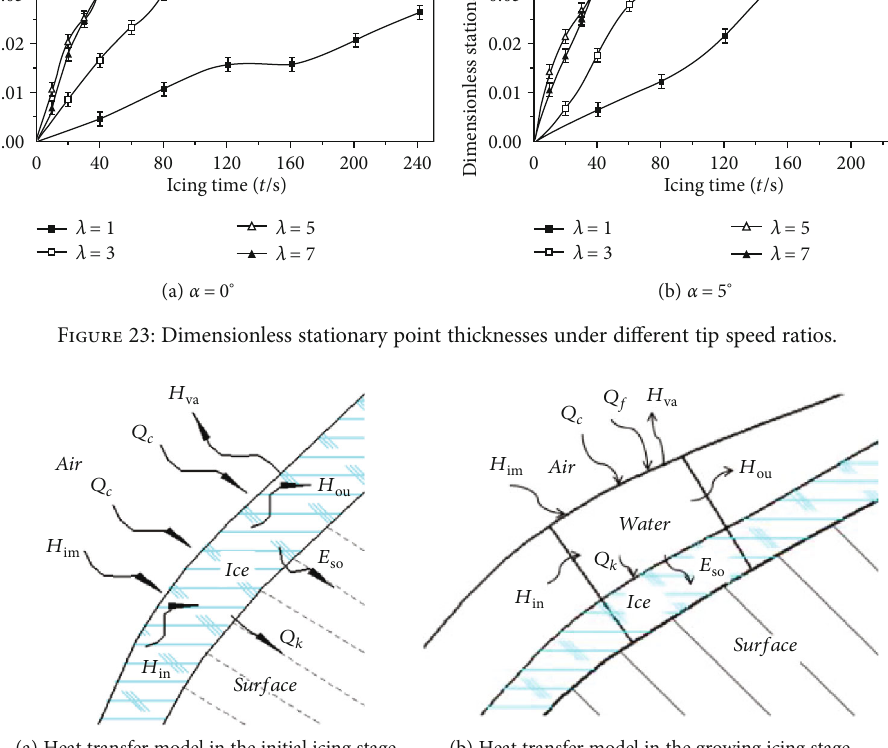
Figure 24: Heat transfer model in di ff erent icing